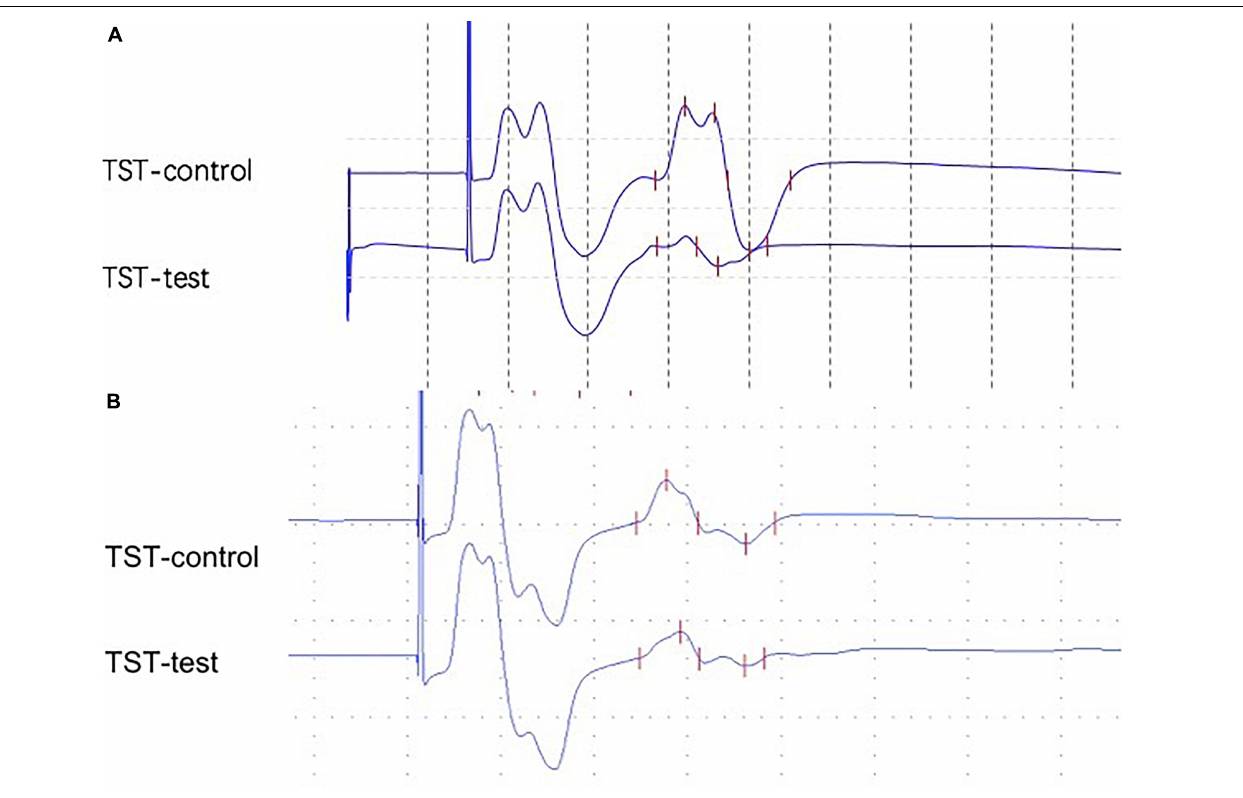
FIGURE 1 | (A) Abnormal TST ratio (21.0%) from a 59-year-old female with a 2-year PD (patient 21). (B) Abnormal TST ratio (53.0%) from a 48-year-old male with a 1-year MSA-P (patient